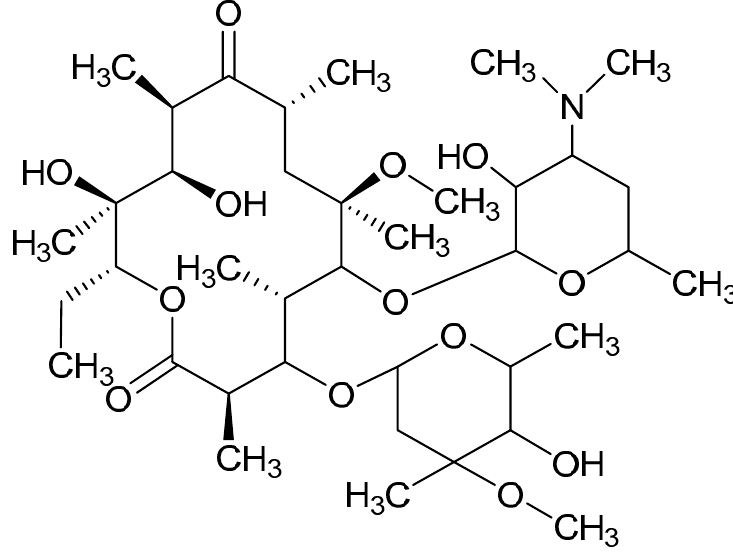
Figure 1. Chemical structure of clarithromycin (CLA) (C 38 H 69 NO 13, MW = 747.96 g/mol) [24].